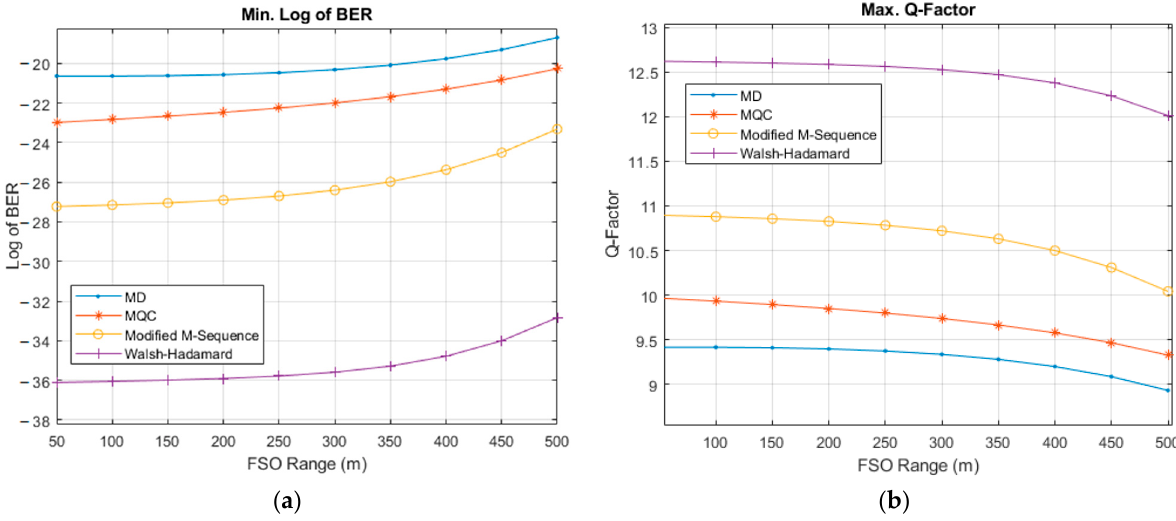
Figure 10. Performance of the system in intense rainy weather for the AWGN channel: ( a ) min. log of BER; ( b ) max. Q-factor.